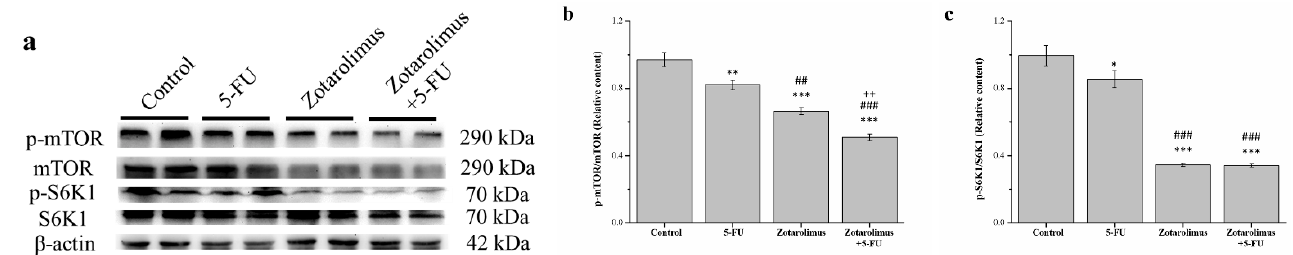
Figure A2. Western blot analysis of ( a ) mTOR signaling and the relative quantitative expression of ( b ) mTOR phosphoryla- tion and ( c ) S6K1 phosphorylation in A549 tumors taken from BALB/cByJNarl mice provided with different treatments, including control, 5-FU (100 mg/kg/week), zotarolimus (2 mg/kg/day), and zotarolimus (2 mg/kg/day) combined with 5- FU (100 mg/kg/week). All data are presented as mean ± standard deviation, n = 7 per group. * p < 0.05, ** p < 0.01 and *** p < 0.001 compared with the control group. ## p < 0.01 and ### p < 0.001 compared with the 5-FU-treated group. ++ p < 0.01 compared with the zotarolimus-treated group.